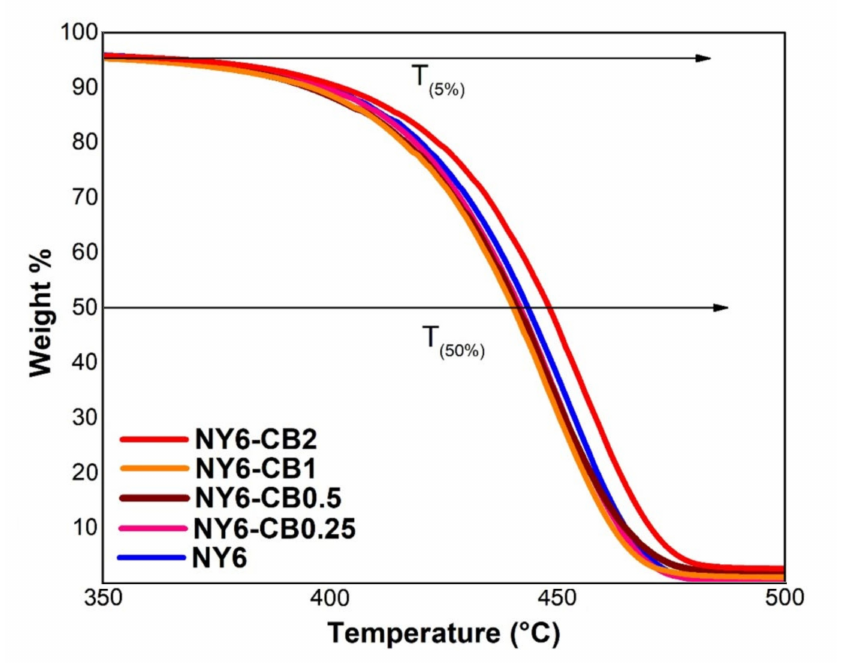
Figure 6. Thermogravimetric analysis of the Nylon 6 and NY6 / MCB60 nanocomposites.